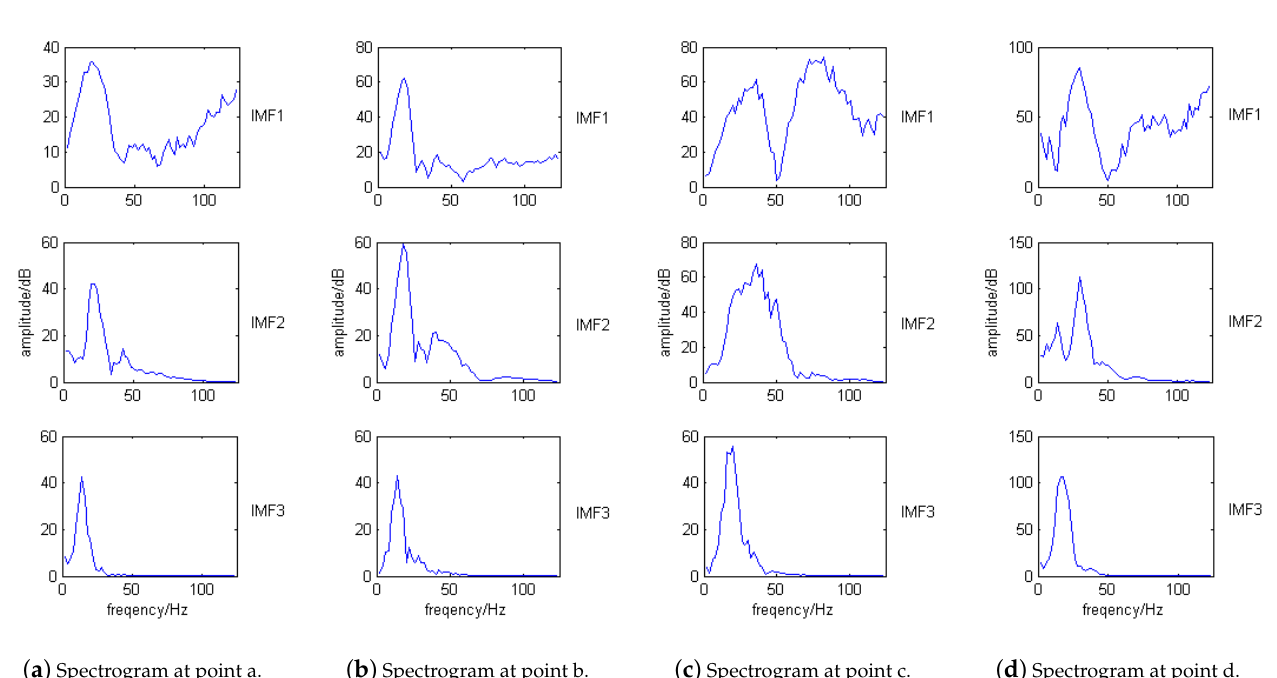
Figure 12. Spectrum of the first three-order EMD components at points